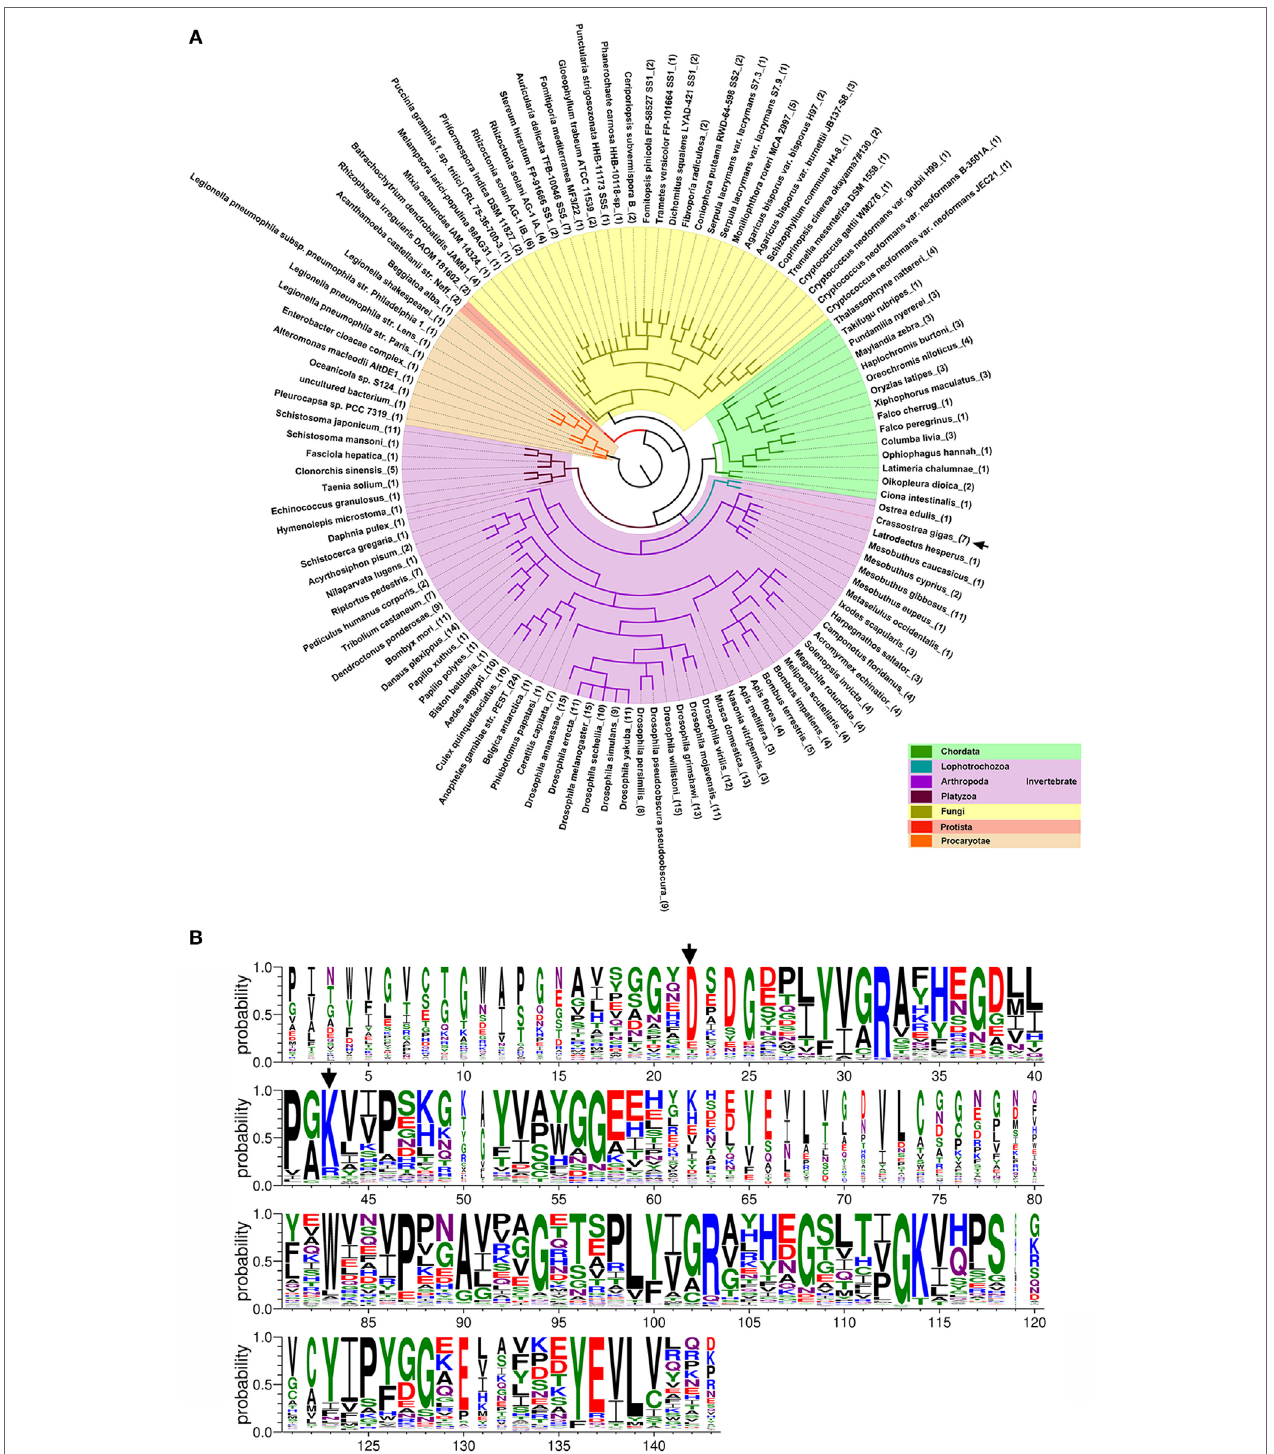
FigUre 6 | Conserved features of DM9 domain containing proteins (DM9CPs). (a) Maximum likelihood phylogenetic tree of 477 DM9CPs annotated from the released genomes. Procaryotae, Protista and Fungi Kingdom are color-coded with brown, red, and yellow, respectively. The invertebrates and chordats in Animalia kingdom are color coded with purple and green, respectively. The DM9CPs in Crassostrea gigas were indicated by a black arrow. (B) WebLogo sequence alignment of DM9CP proteins identified with BLASTP. CgDM9CP-1 and another 476 annotated DM9CPs were used as input for sequence comparison. The residues (Asp22 and Lys43) involved in the ligand binding were highly conserved and marked by black